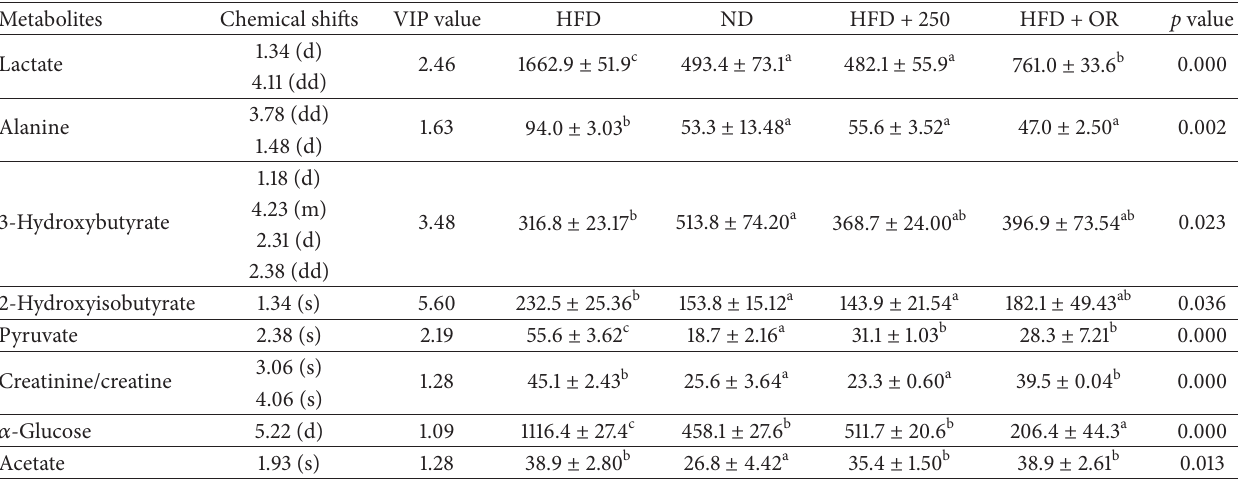
Table 5: Relative quantification of significant discriminating metabolites based on the concentration of 0.1% of 3-trimethylsilyl